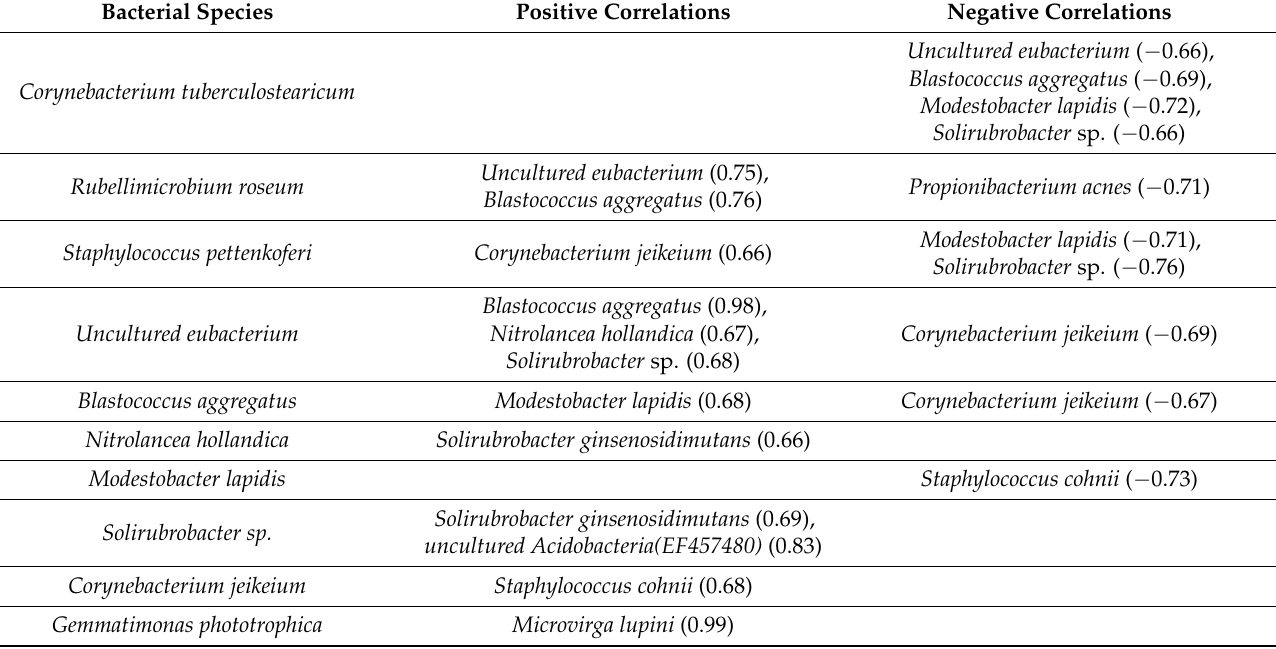
Table 3. Relationships among the 20 selected bacterial species based on the ρ metrics proportionality. Only significant positive ( ρ values > 0.65) and negative ( ρ values < − 0.65) values are reported in the